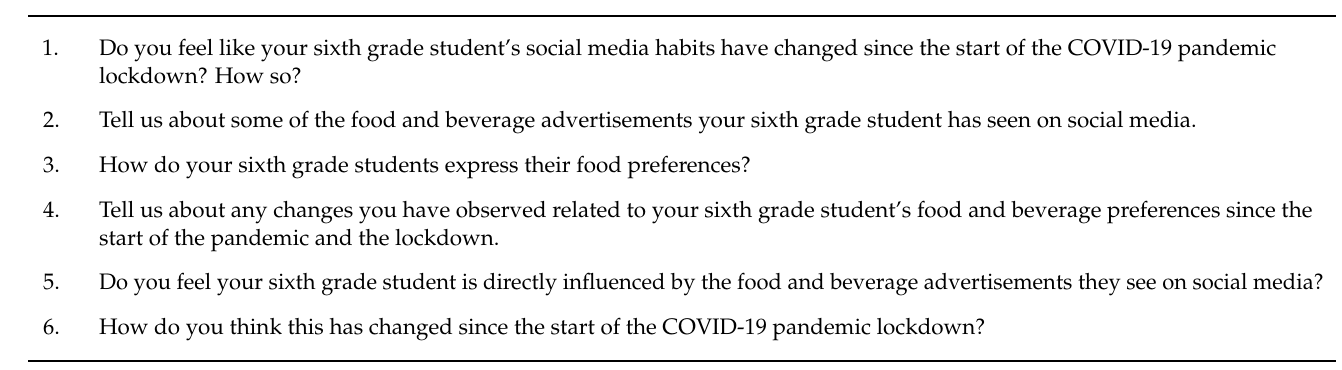
Table 2. Example Questions from Semi-structured Group Interview Guide for